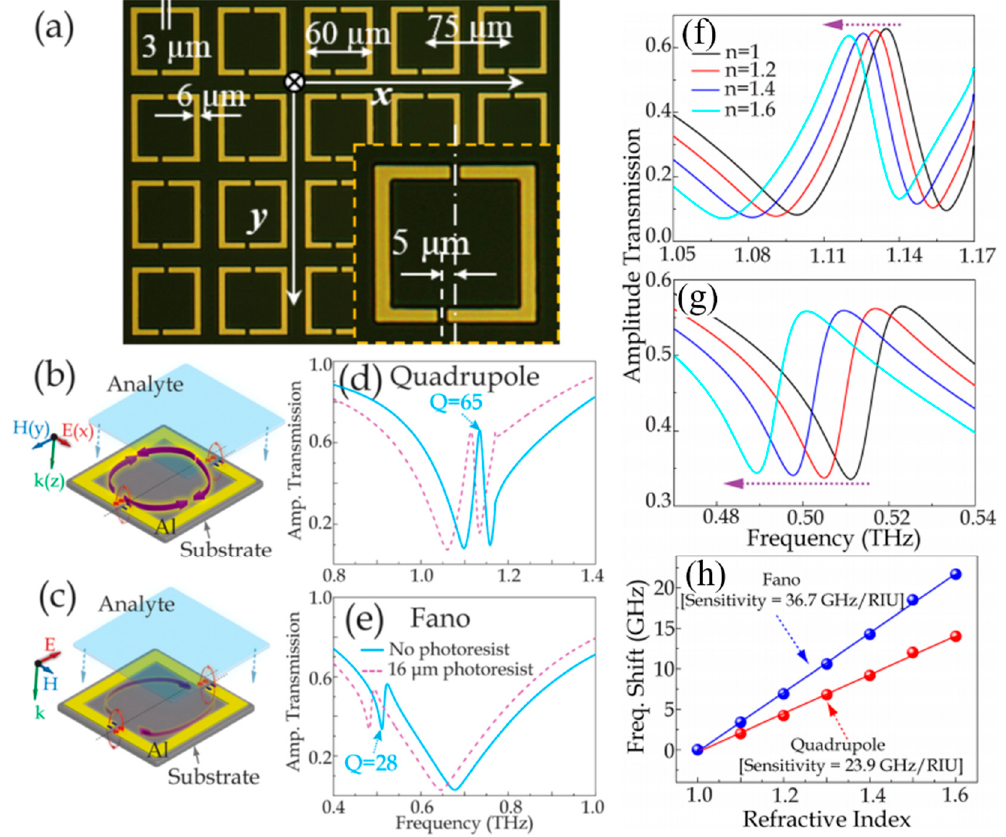
Figure 10. Refractive index sensing. ( a ) Optical microscope image of the terahertz asymmetric resonator array with dimensions. Illustration of the illumination conditions for excitation of the metasurface’s ( b ) quadrupole and ( c ) Fano resonances alongside transmission spectra of the ( d ) quadrupole and ( e ) Fano resonances with and without an analyte layer. Simulated amplitude transmission spectra of ( f ) quadrupole resonance and ( g ) Fano resonance when a 4- μm -thick analyte coating with different refractive indices is placed on an asymmetric split ring metasurface. ( h ) Shift of the quadrupole and Fano resonances as a function of refractive index. Adapted with permission from ref [102], AIP Publishing.